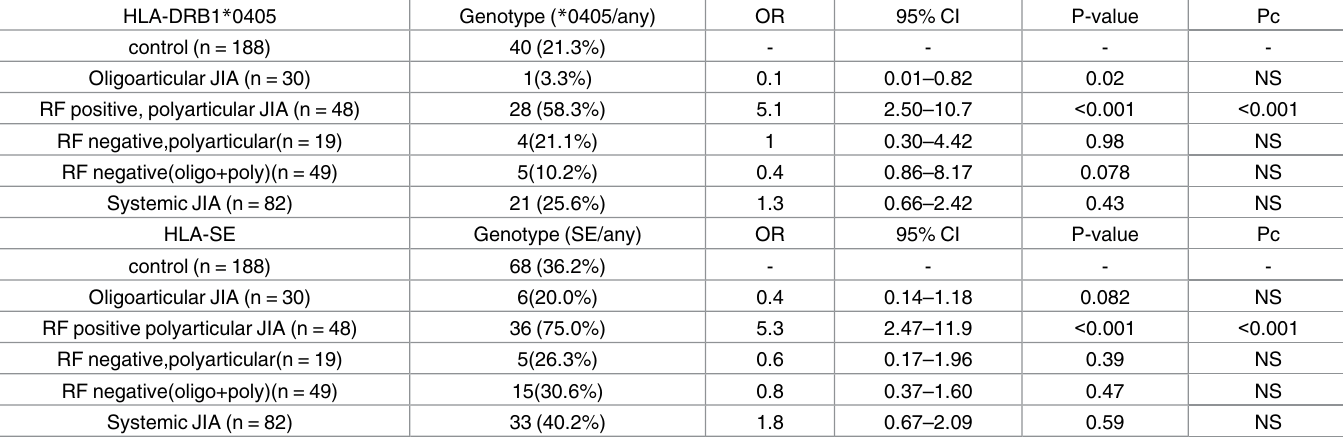
Frequencies of PADI4 gene polymorphisms studied in JIA patients and controls are shown in Table 3. There were no associations between clinical subtypes of JIA and PADI4 gene poly- morphisms. Nonetheless, the PADI4 SNPs were significantly associated with ACPA positivity in JIA (Table 4). Because the ACPA status of all systemic JIA patients measured in this study was negative (0/43), systemic JIA was excluded from the data in Table 4. Hence, the A allele at rs2240337 is a significant risk factor for ACPA positivity in oligo- and poly-articular JIA (OR = 5.6, 95% CI = 1.7–24 Pc = 0.03). Finally, there were no associations between HLA-SE and PADI4 gene polymorphisms in oligo- and poly-articular JIA (Table 5). Table 2. Association of HLA-DRB1 * 04:05and HLA-SE with susceptibility to JIA subtypes. HLA-DRB1 *